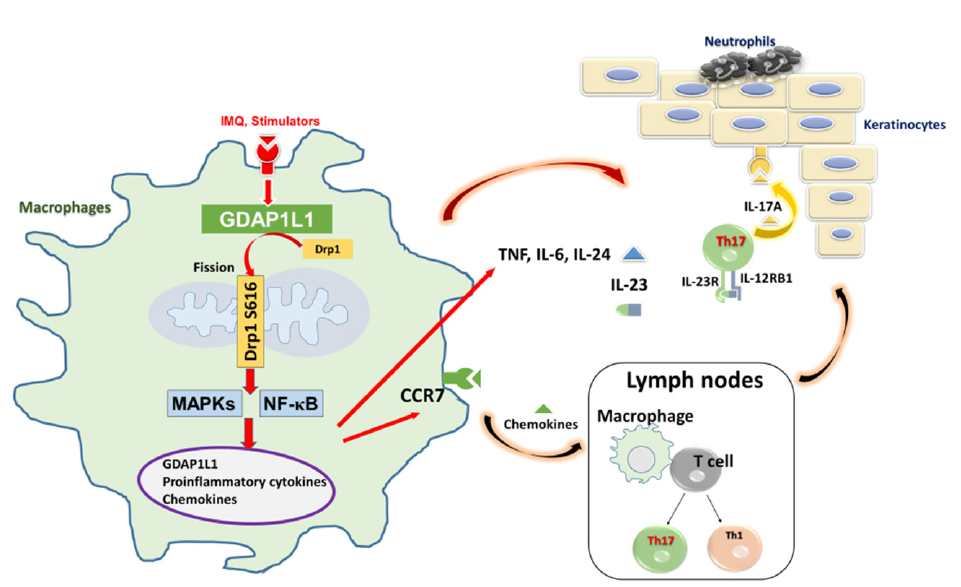
Figure 7. Schematic representation of GDAP1L1-modulated macrophage trafficking and inflamma- tion cytokine responses to regulate psoriatic skin inflammation. The activation of antigen-presenting cells, such as macrophages, initiated the development of psoriatic inflammation. The ligand of TLR 7/8, IMQ, activated cytokine and chemokine production in macrophages through MAPK and NK- κ B phosphorylation, which was in the GDAP1L1-dependent manner. Activated macrophages could traffic to the skin-draining lymph node and the dermis via vessel and contribute to T cell-mediated and epidermis-mediated psoriasiform skin inflammation. In turn, the cytokines and chemokines from activated macrophages rescued neutrophils, which caused epidermal proliferation. We found that IMQ induced GDAP1L1-dependent Drp1 S616 phosphorylation and then caused mitochondria translocation of GDAP1L1 and phosphorylated Drp1 S616, leading to mitochondrial fission, which played an important role in macrophage trafficking and inflammatory cytokine